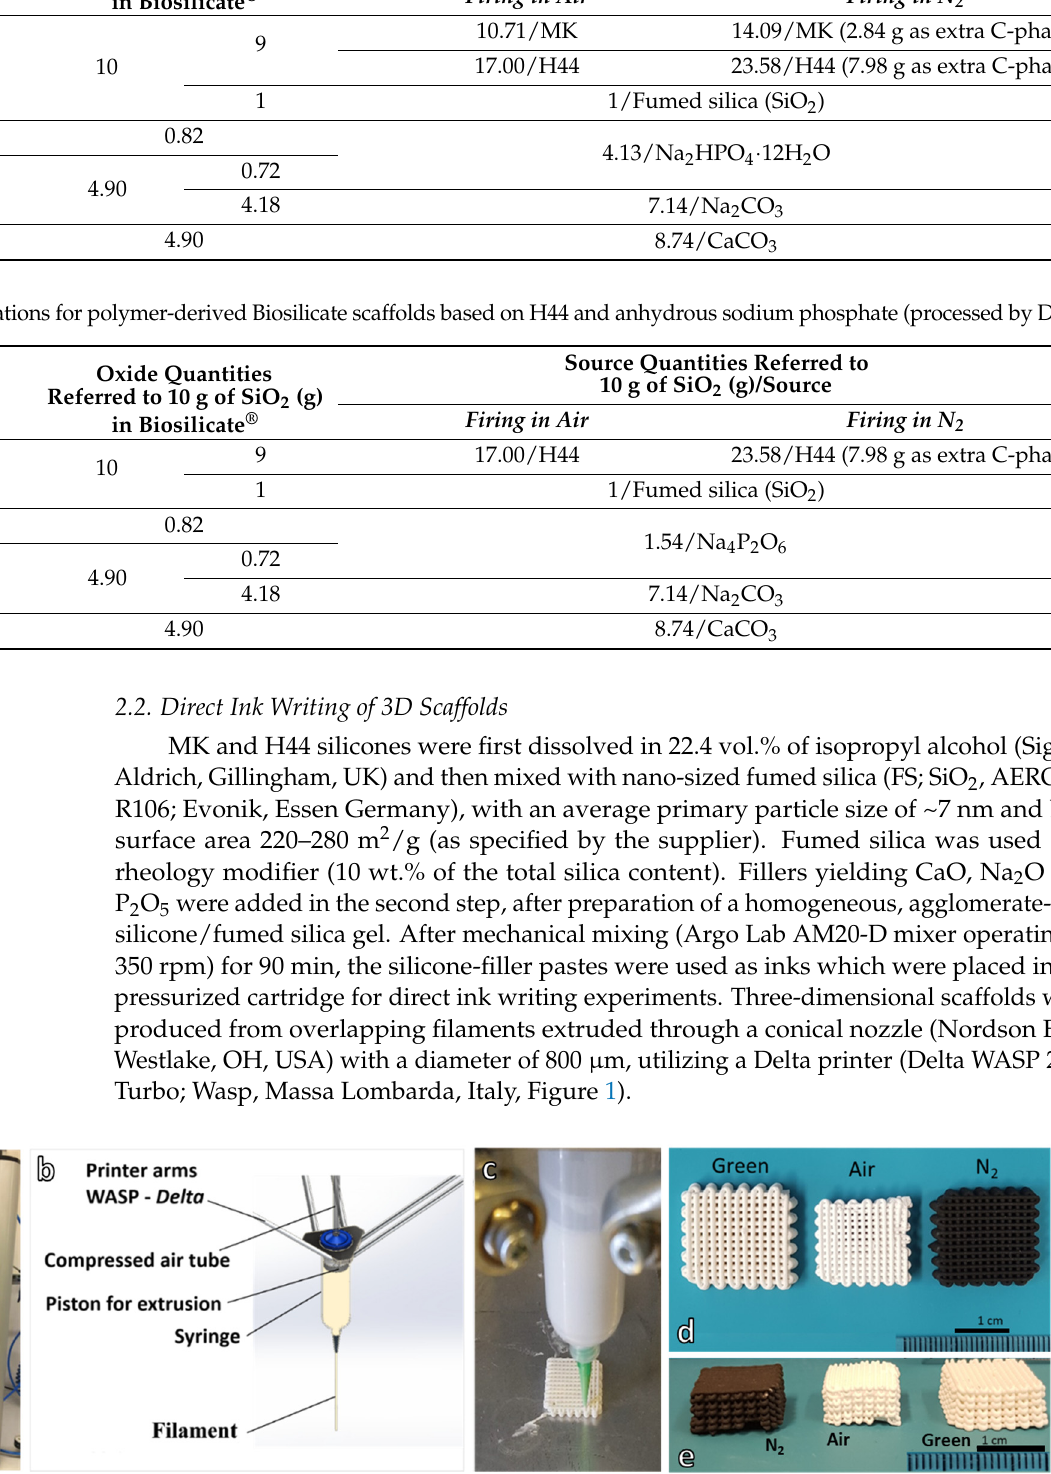
Figure 1. Direct ink writing experiments: ( a ) overall view of the printer; ( b ) scheme of the printing head; ( c ) printing head during operation; ( d , e ) examples of MK-based scaffolds in green form, before heat treatment and after treatment in air and N 2 atmosphere .